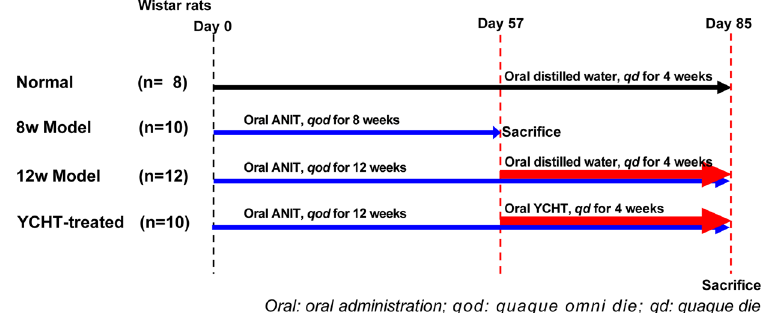
Figure 1. Scheme of the